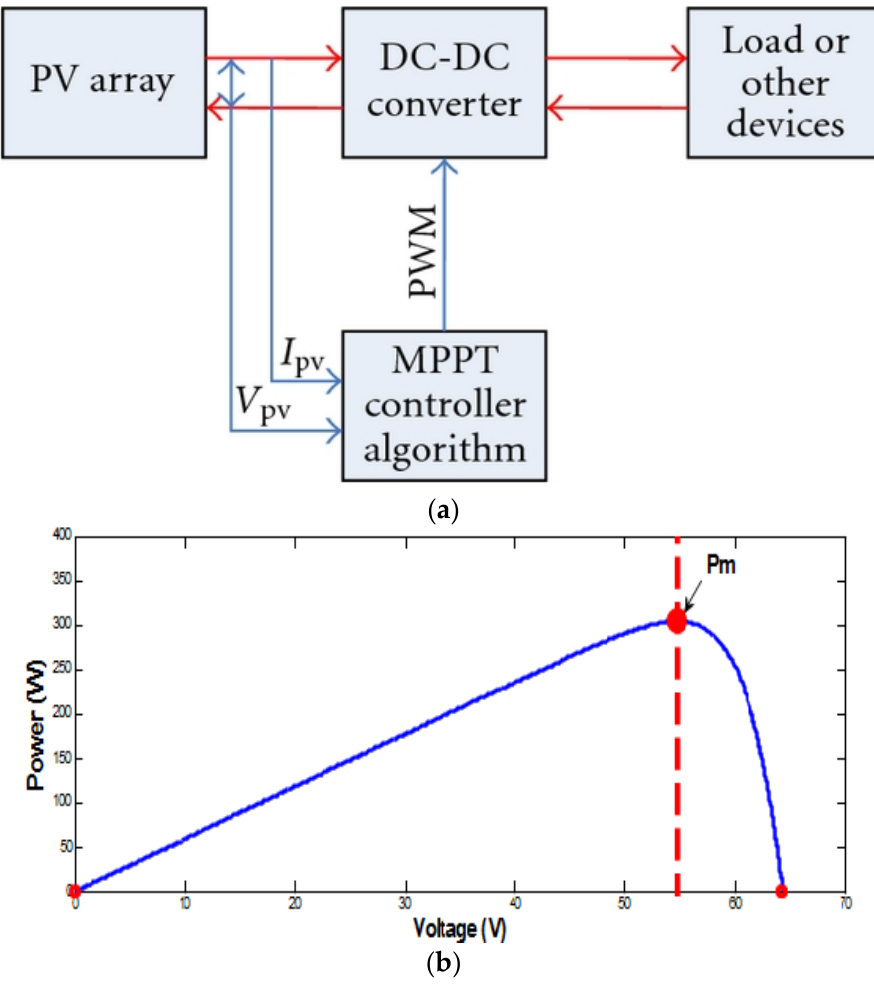
Figure 2. ( a ) Controller model; ( b ) P–V curve.